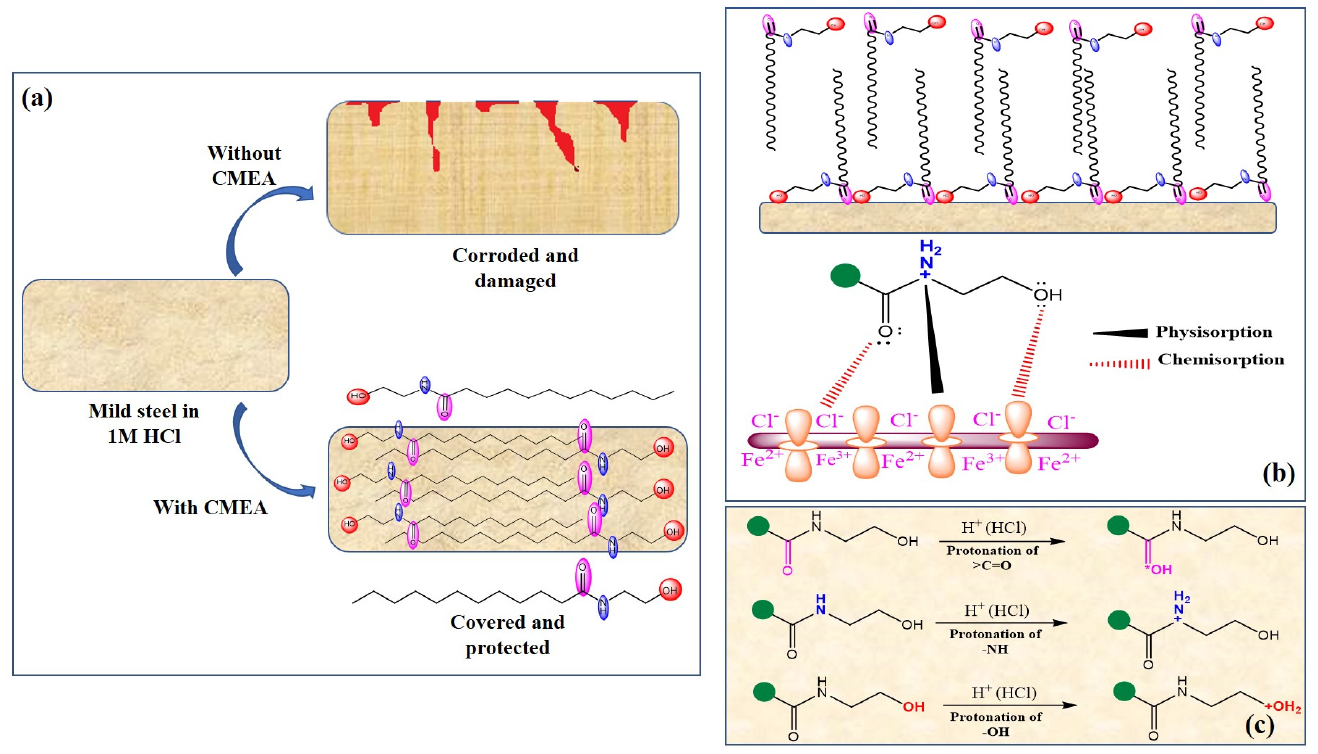
Figure 16. ( a ) The mechanism of corrosion inhibition. ( b ) Physisorption and chemisorption and ( c ) Protonation of different functional groups in 1 M HCl.